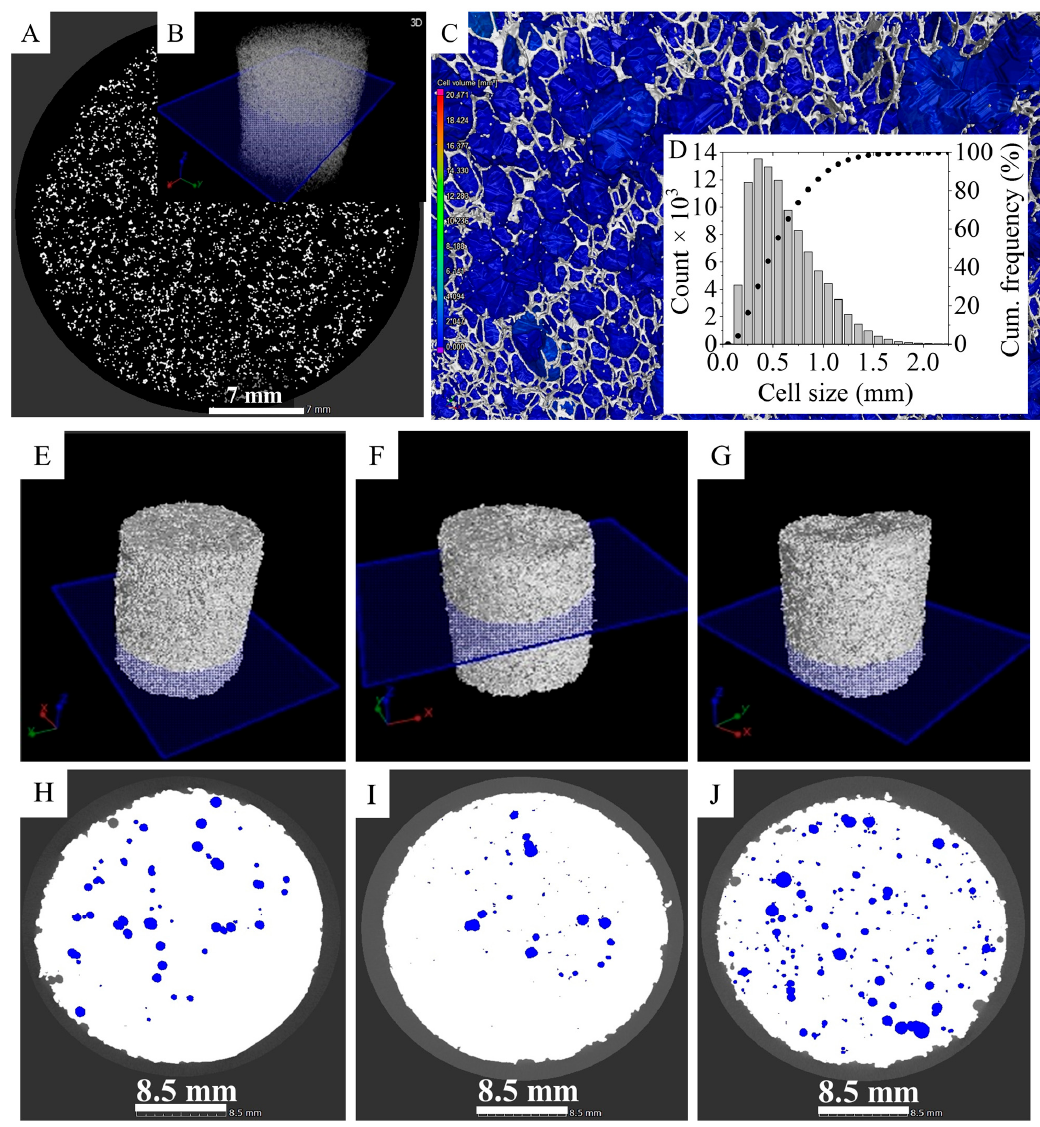
Figure 4. ( A ) Micro-CT image of the PU foam. ( B ) The mapping plane’s location in the sample. ( C ) Cell structure (blue: pores, grey: walls) and ( D ) size distribution. Micro-CT images of the N-BCNT/PU-silicone rubber nanocomposites. Position of the mapping plane and CT scan of sample 1—( E , H ), sample 2—( F , I ), and sample 3—( G , J ). The white and blue areas are filled and not filled with silicone rubber, respectively.